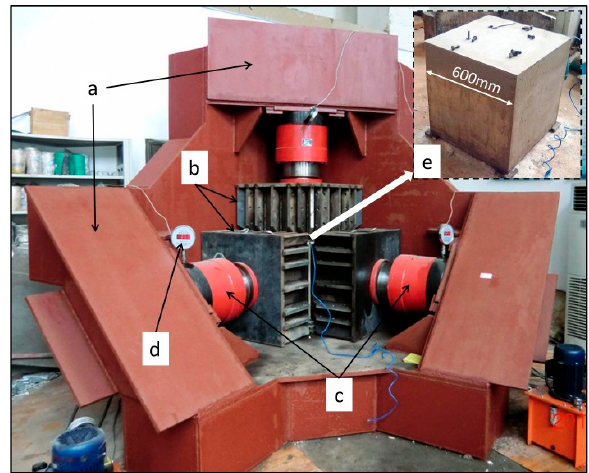
Figure 11. Model tests on a cement mortar body. ( a . steel support frame; b . steel dowels; c . hydraulic jack; d . pressure gauge; e . cement mortar body with a transducer embedded in the middle).